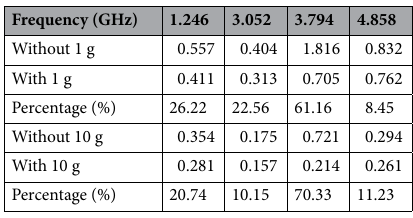
Table 10. Array metamaterial position 4.